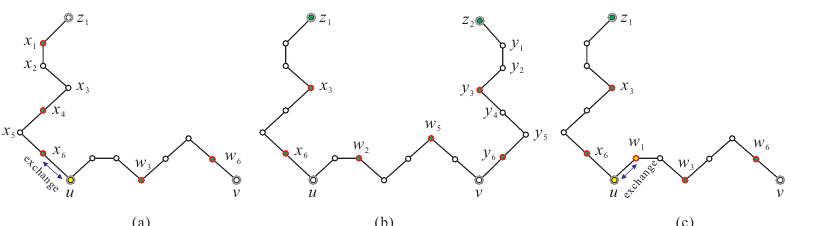
Figure 8. The dominating set of snake path S ( u , v ) in G d where u , v (cid:54)∈ D (cid:48) , where ( a ) z 1 (cid:54)∈ D (cid:48) ,